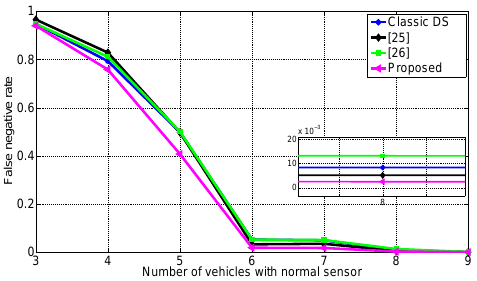
Figure 9. Comparisons of the false negative